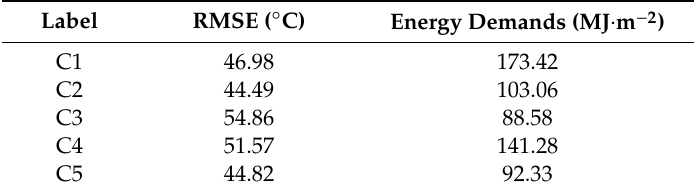
Table 6. Evaluation of agreement of optimal and calculated firing temperatures of particular clays.